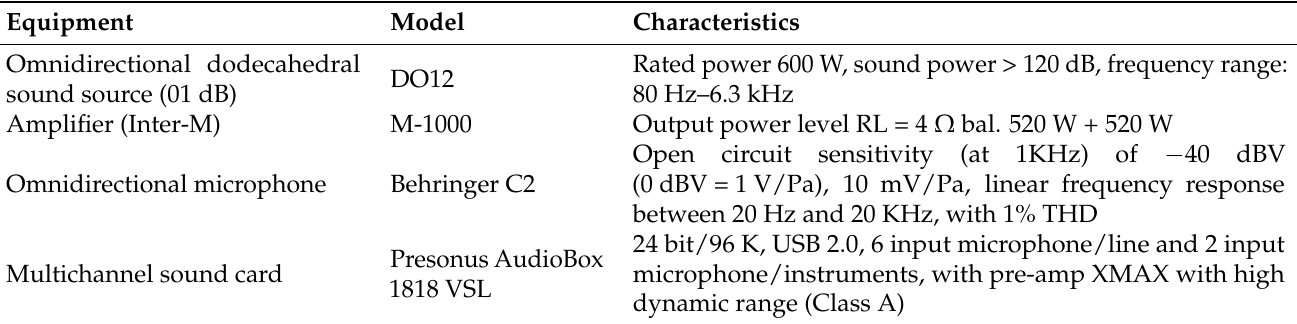
Table 1. Specific characteristics of the equipment used during acoustic measurement of the environ- ment of the Water